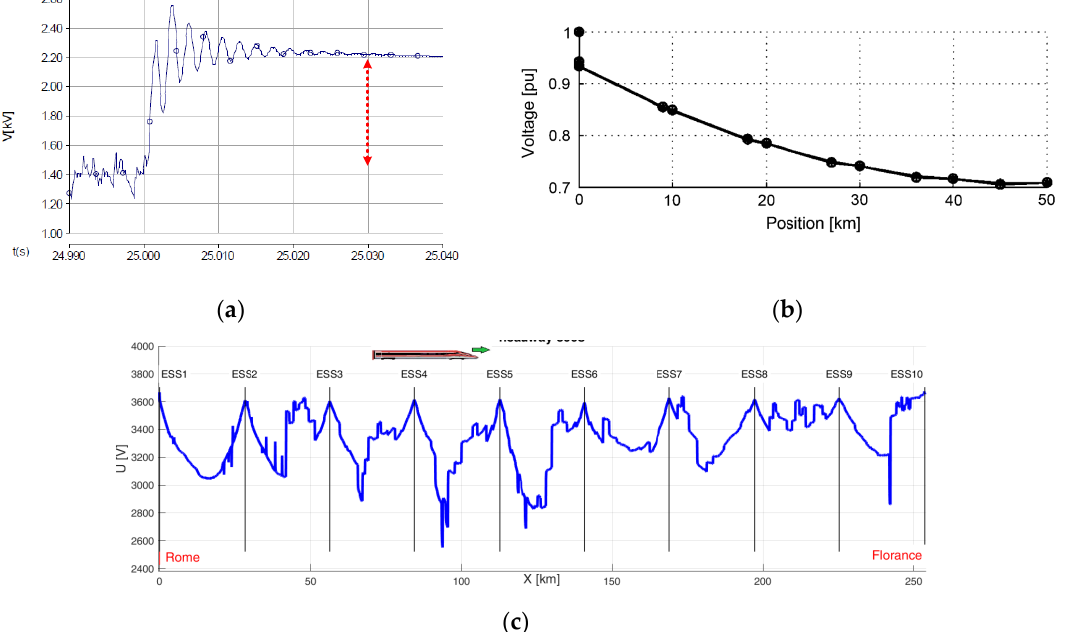
Figure 18. The measured overvoltage and under voltage in ERPS. ( a ) Overvoltage situation during braking of trains in Metro de Medellin without dissipating resistance [117] ( b ) Voltage drop/undervoltage in 25 kV ERPS [120]. ( c ) Simulated voltage drop across the Rome–Florence HSR line.